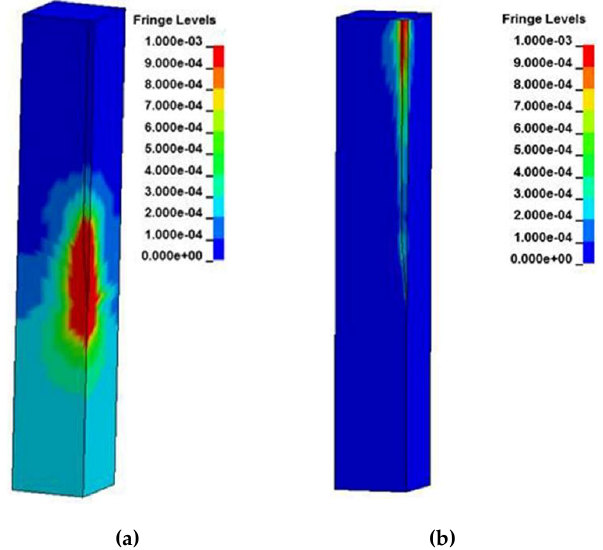
Figure 4. Strain distribution of the brain using a micromotion displacement of 4 µm and interfaced with a ( a ) silicon probe and ( b ) 200 kPa stiff probe.